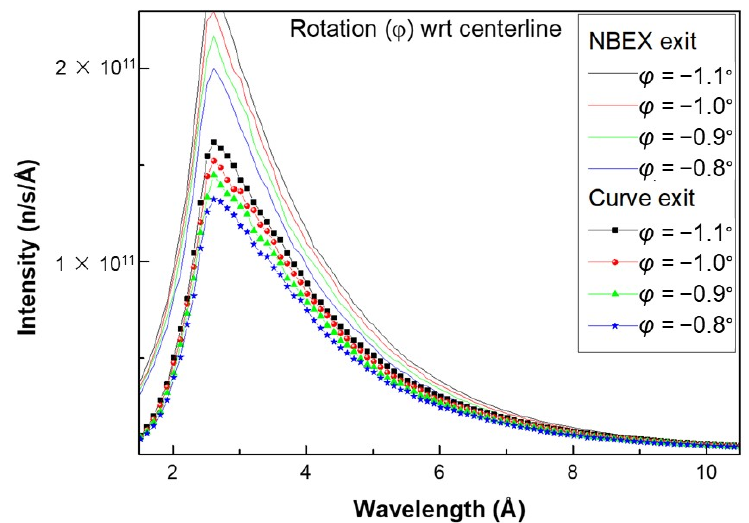
Figure 4. Spectra profile at the exit of the NBEX (7.7 m from the moderator) and at the exit of the curved guide (37 m from the moderator, assuming a curve with radius R = 1400 m) for different rotation angles.